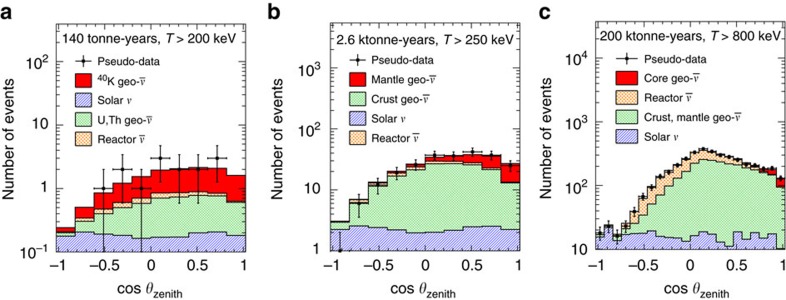
Zenith angle distribution of electron recoils induced by neutrinos.Zenith angle distributions of electron recoils induced by signal geo-neutrinos from: (a) potassium (40K) decays; (b) the mantle, assuming no radioactivity in the core; and (c) the core, assuming 10 p.p.b. uranium and thorium in the core. Signal-induced recoils (red solid) are shown together with recoils induced by background geo-neutrinos (green hatched), solar neutrinos (blue striped), and reactor antineutrinos (orange weave). Pseudo-experimental data (black squares) are also shown, with their statistical errors. Recoil distributions are calculated at Gran Sasso (Italy) and normalized to an exposure of (a) 140 tonne-years, (b) 2.6 ktonne-years or (c) 200 ktonne-years, including the effect of neutrino oscillation, with an applied electron energy threshold of T>(a) 200 keV, (b) 250 keV or (c) 800 keV. Reconstructed angles have been smeared with a Gaussian distribution according to the angular resolution parameterization given in equation (1). The zenith angle (θzenith) is measured with respect to the vertical axis, defined opposite the direction pointing to the centre of the Earth. A cut requiring a minimum angular separation from the Sun (θsun) has been applied in order to reject the dominant background from solar neutrino events: cos θsun<(a) −0.09, (b) 0.02 or (c) 0.54.